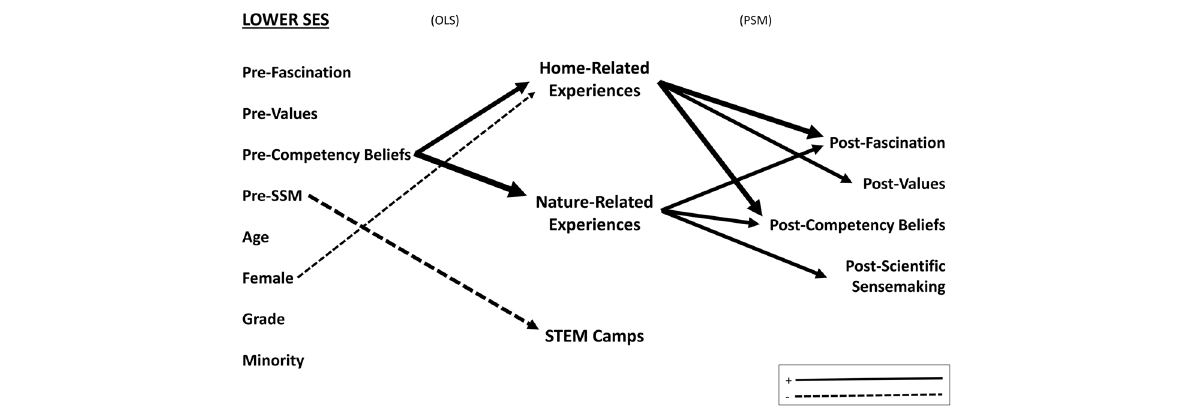
Fig. 4 Summary of characteristics that influence optional summer science experience participation (from the OLS models of participation) and how participation influences post-summer outcomes (from the PSM models of impact) for Lower SES participants